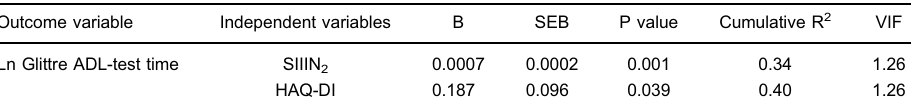
Table 3. Stepwise forward regression analysis for the phase III slope of the nitrogen single-breath washout using demographic, anthropometric and clinical data, lung function, physical function, and chest computed tomography fi